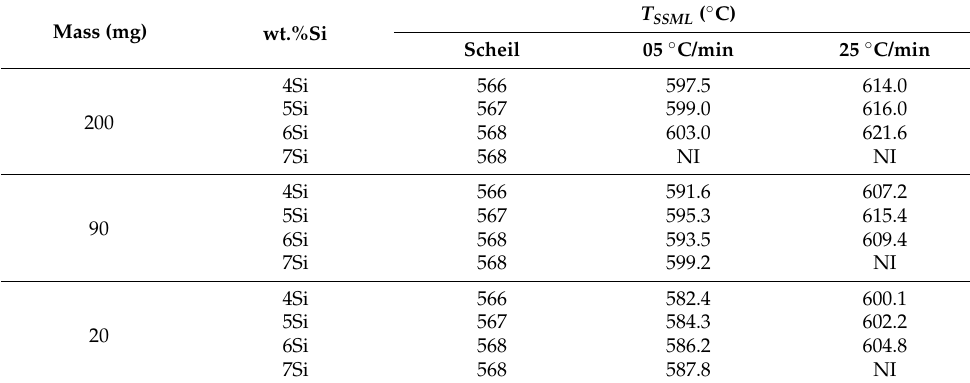
Figure 13. f S vs. T curves for 4 to 7 wt.%Si from CALPHAD simulation at the Scheil condition and DSC curves for heating rates of 5 and 25 ◦ C/min and 200 ( a ), 90 ( b ) and 20 mg ( c ) DSC samples. Table 8. The T SSML for Al X Si 4 Zn in the Scheil condition, 05 ◦ C/min and 25 ◦ C/min, with sample mass 200 mg, 90 mg and 20